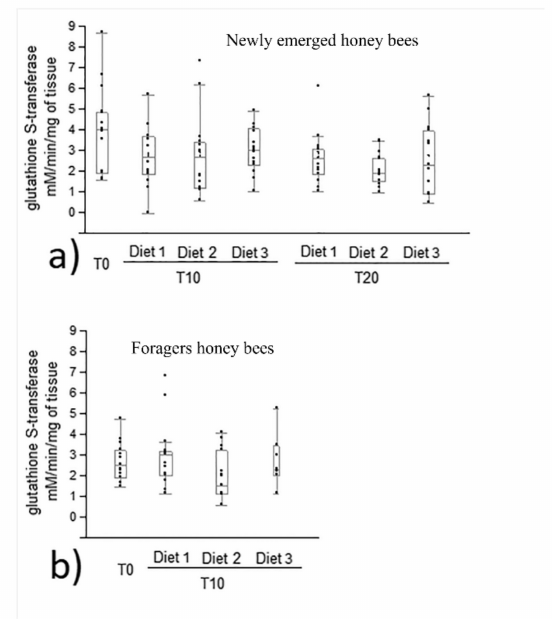
Figure 5. Glutathione S-transferase activity in newly emerged ( a ) and forager ( b ) honey bees fed control and experimental diets (diet 1, diet 2, diet 3 with 0.3%, 1.7% and 7.7% of protein content, respectively). No statistical differences were observed by Kruskal–Wallis test ( p > 0.05). Glutathione S-transferase activity was expressed as mM/min/mg of tissue (median, min and max values). T0, T10, T20 were the days of honey bee sampling, n = 15 per